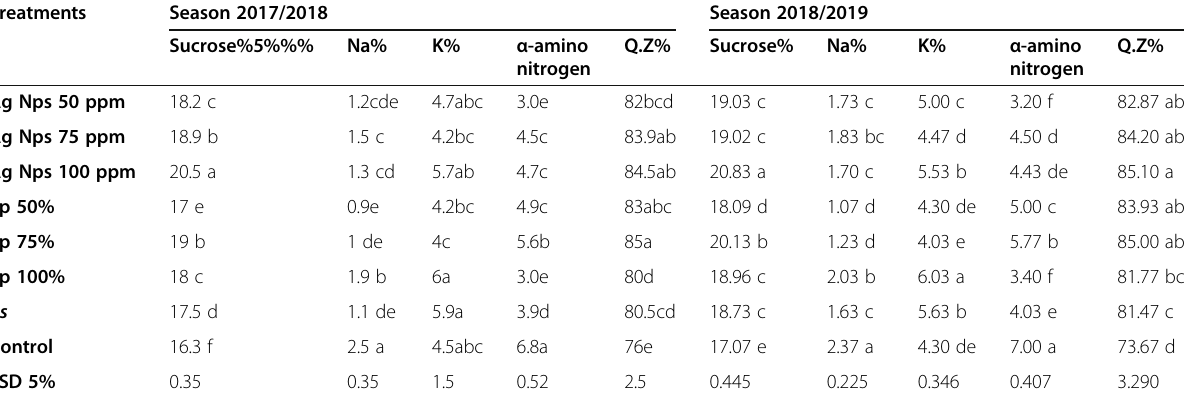
Table 4 Chemical composition of the roots after different treatment